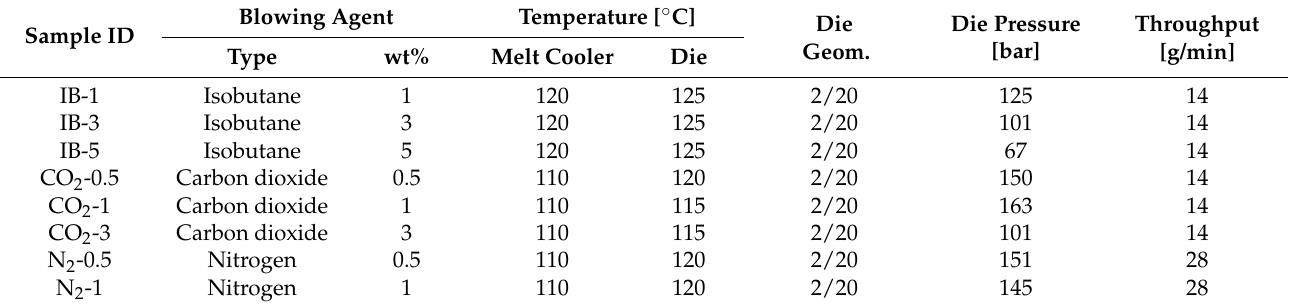
Table 1. Foaming parameters of prepared cellulose palmitate foam